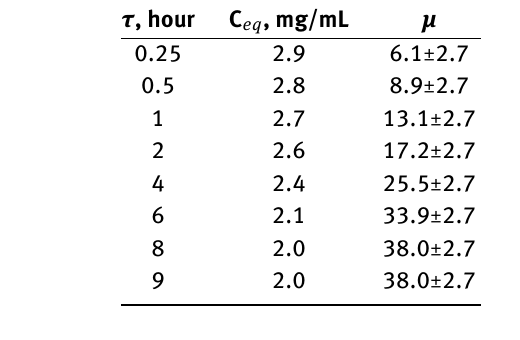
From the presented data, it was observed that at the initial concentration of palladium exceeding 2.9 mg/mL, the equilibrium concentration was 1.6 mg/mL. The sorp- tion capacity reached its maximum value of 38.0±2.7 mg/g. by the equation of the Freundlich isotherm, n = 0.60, k = 28.8 (Fig. 5).